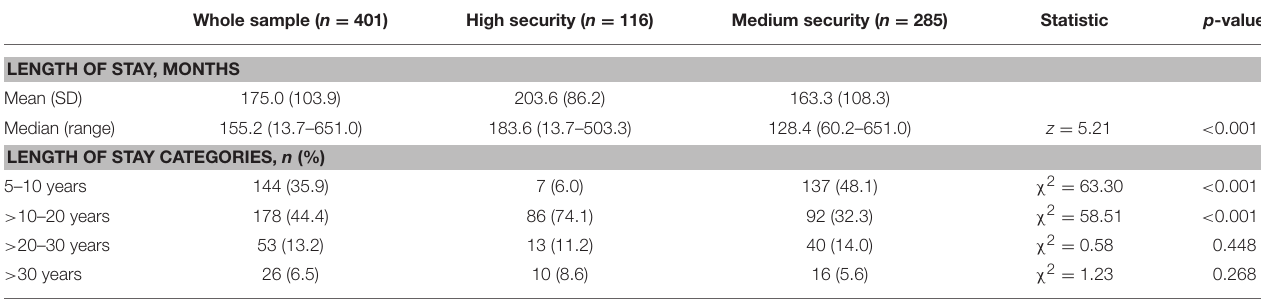
TABLE 2 | Length of stay in continuous care for long-stay forensic